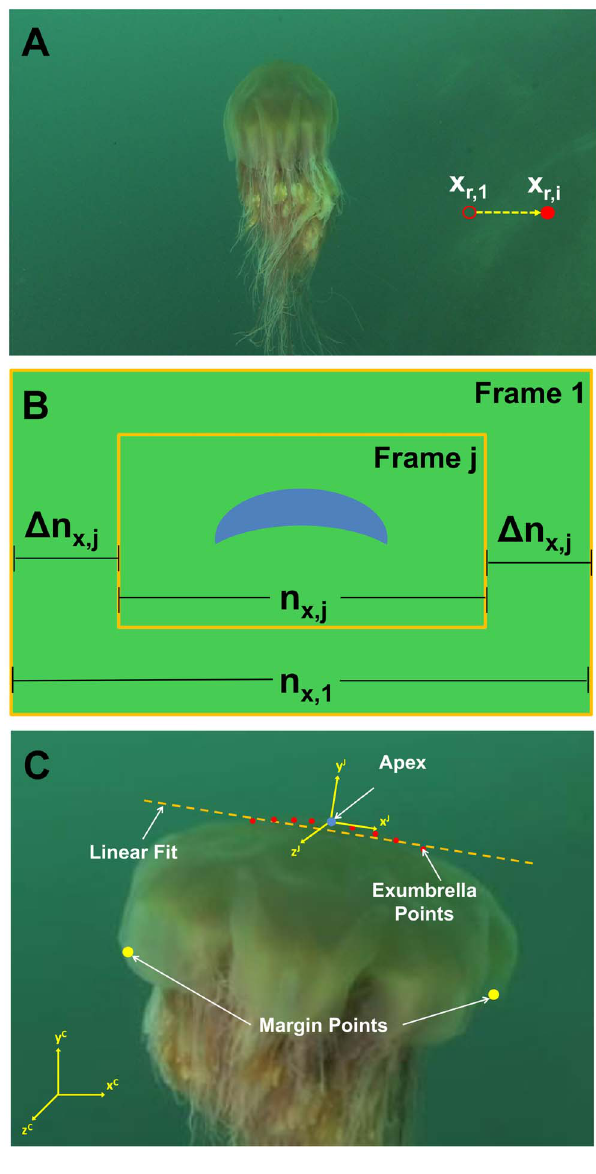
Fig. 4. Correction technique illustration. Illustrations of how image magnification was compensated by using a reference point on the ocean floor. (A) Frame of the C. capillata footage with reference rock highlighted by a red hollow dot in the first frame and red dot in frames j . 1. (B) Schematic of magnification correction technique using a background reference point. (C) Schematic of the method used to account for the body rotation about the z J -axis and z C -axis. The red dots represent the exumbrella points c ƒ i ƒ d which meet the 24% criteria. The linear fit was calculated from these exumbrella points.